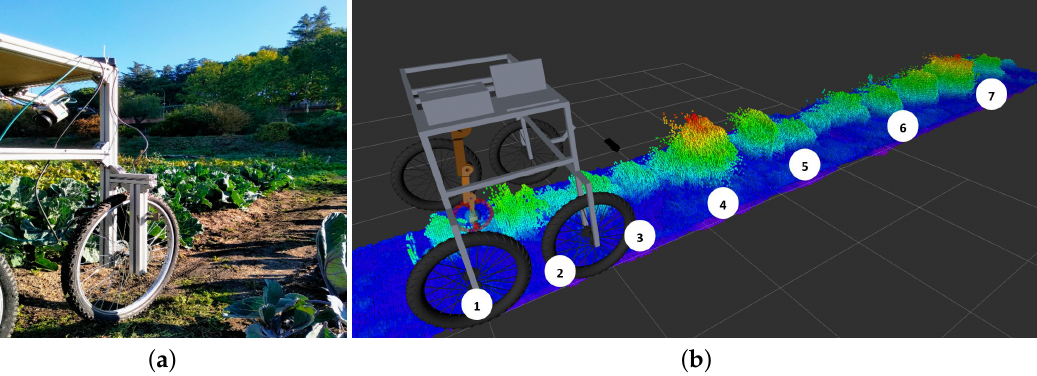
Figure 9. Test execution and data visualization for localisation. ( a ) Mobile robotic platform—on field, ( b ) mobile robotics platform position and data visualization in rviz. Source: Authors.